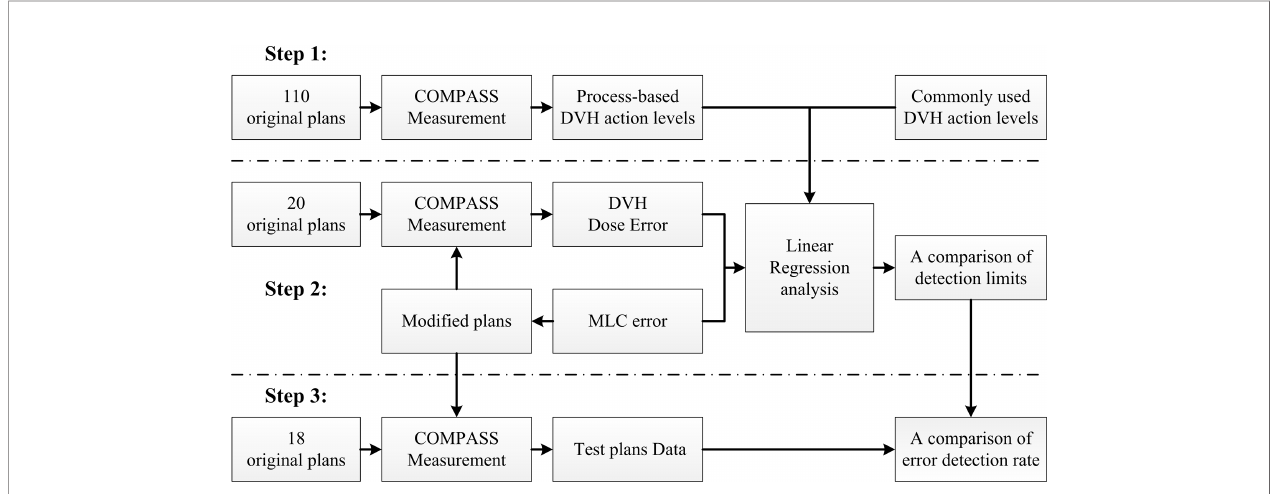
FIGURE 1 | Flowchart of DVH-based action levels